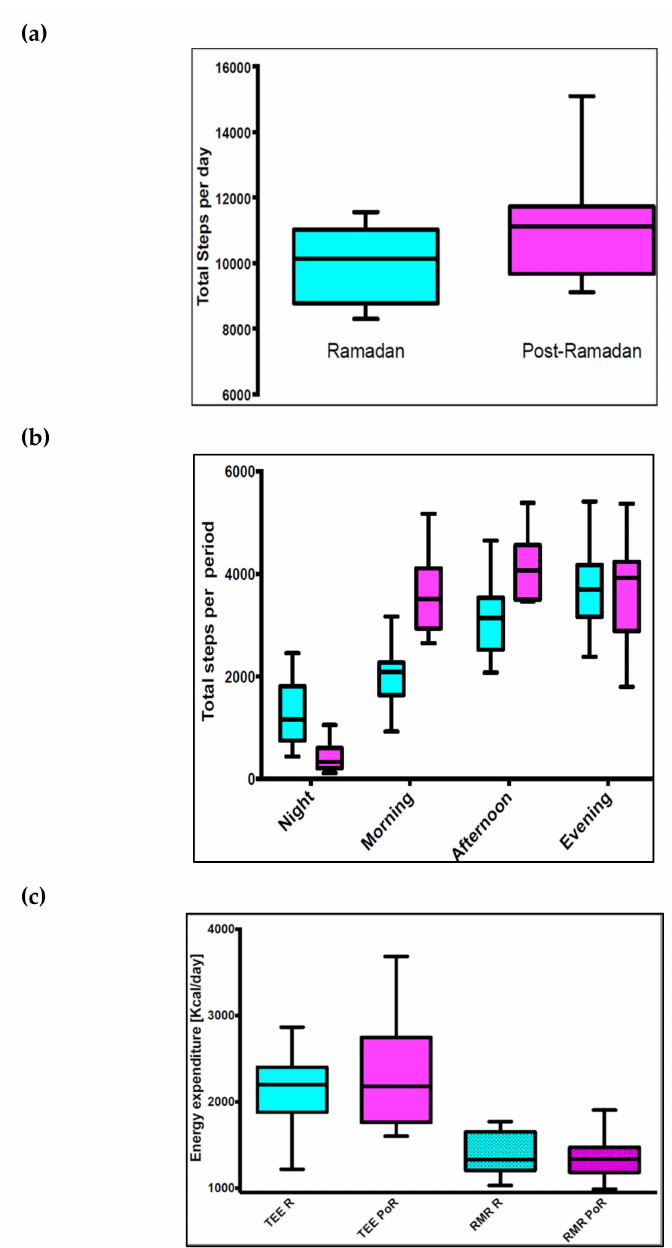
Figure 4. Energy expenditure and physical activity pre-, during and post-Ramadan. ( a ) Box plot of daily total number of steps during and post-Ramadan. The e ff ect of Ramadan fasting on activity in 11 participants. ( b ) Box plot of total number of steps at di ff erent periods within one day (per night, morning, afternoon, and evening) during and post-Ramadan in 11 participants. Comparisons made with the Wilcoxon signed-rank test. Total mean ± SD number of steps per day (9950 ± 1152 compared with 11,353 ± 2053, p = 0.001), activity in the morning (1974 ± 583 compared with 3606 ± 715, p = 0.001) and afternoon (3193 ± 783 compared with 4164 ± 670, p = 0.002) were significantly lower during Ramadan compared with post-Ramadan. Nocturnal activity was higher during Ramadan (1261 ± 629 compared with 416 ± 279, p = 0.001). No significant di ff erence in evening activity levels between during and post-Ramadan periods was observed. ( c ) TEE and RMR during and post-Ramadan: the correlation between TEE and weight during and post-Ramadan in 10 participants. No significant di ff erence between Ramadan and post-Ramadan regression lines (ANCOVA; t = 0.35, p = 0.727); the main factor influencing TEE was body weight ( t = 2.72, p =